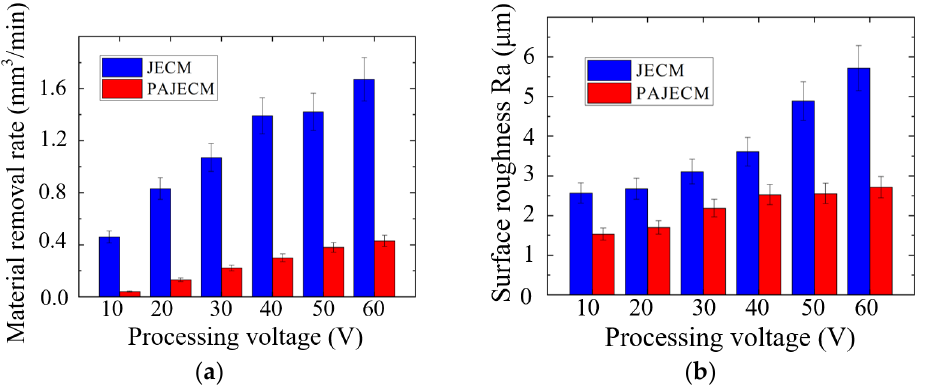
Figure 8. Comparison of experimental results at different processing voltages: ( a ) material removal rate; ( b ) surface roughness Ra.